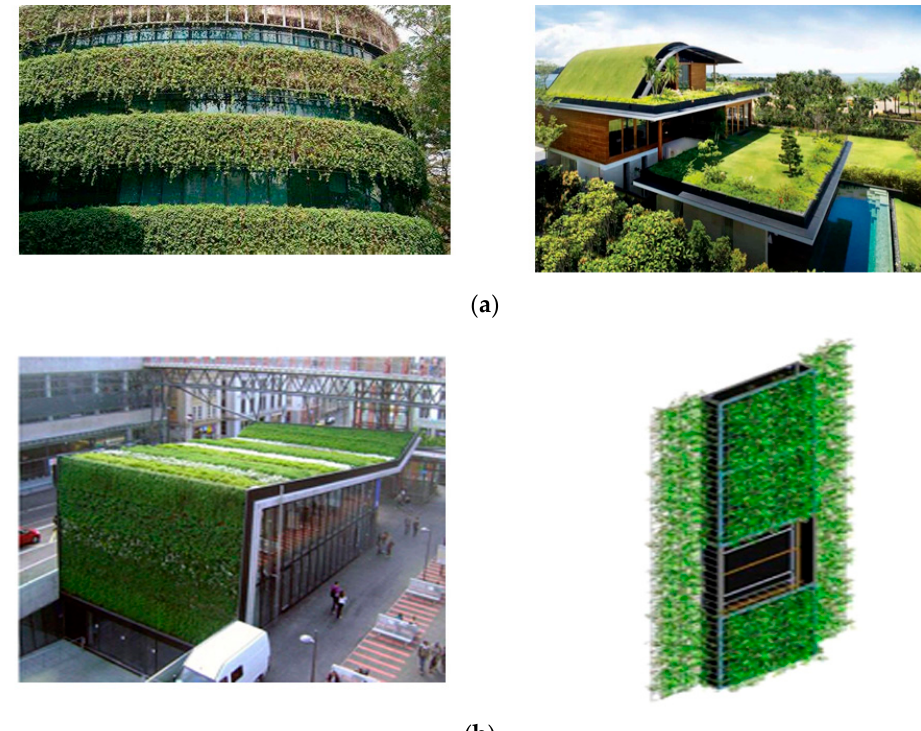
Figure 6. Green shrubs covering substrate wall applications. ( a ) Schematic representation of green buildings, with several services copyrighting the figures, https://www.hqassim.com/green- buildings/, (accessed on 22 March 2022). ( b ) Modular of the green forests covering substrate walls. Copyright for the figures, http://www.canevaflor.com, (accessed on 16 April 2022).